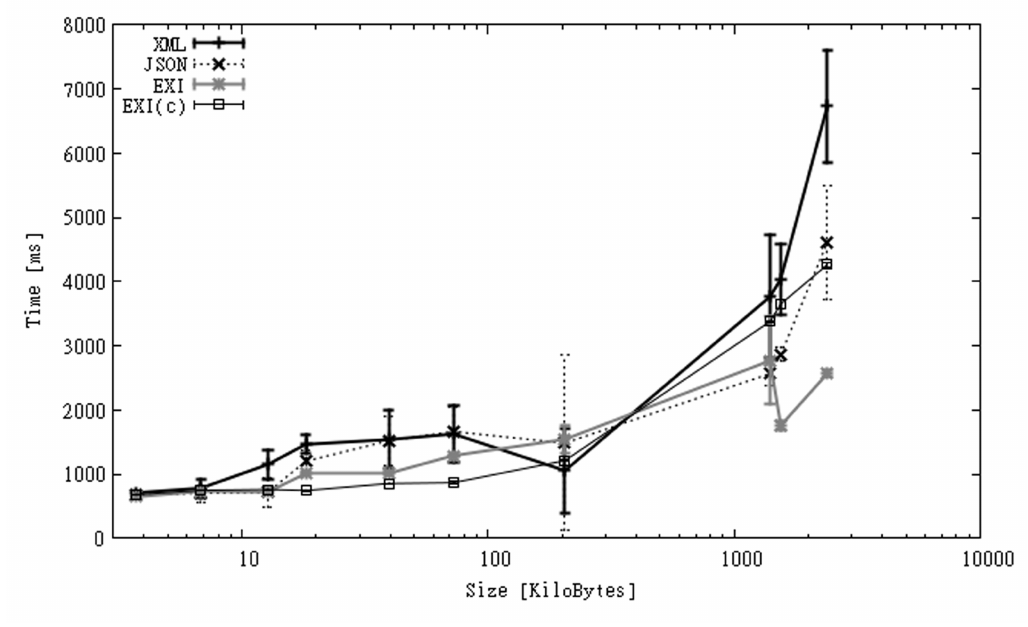
Figure 5. Processing times over a 3G connection for SGS2 smartphone (CAPS